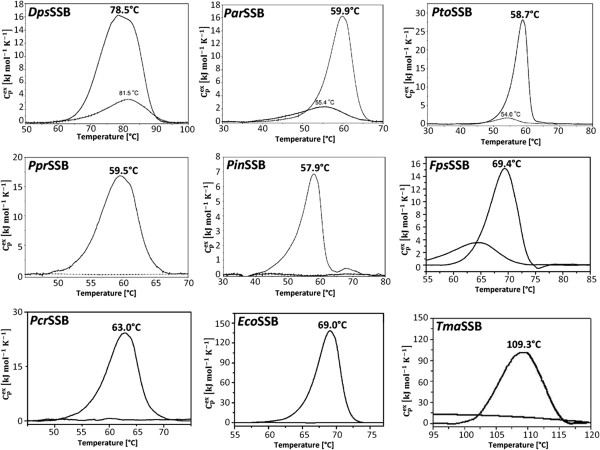
DSC thermograms of SSB proteins. Samples containing 2 mg/ml of the DpsSSB, ParSSB, PtoSSB, PprSSB, PinSSB, FpsSSB, PcrSSB, EcoSSB, and TmaSSB were analyzed in 50 mM of potassium phosphate buffer pH 7.5 and 150 mM NaCl. The melting temperatures are shown.